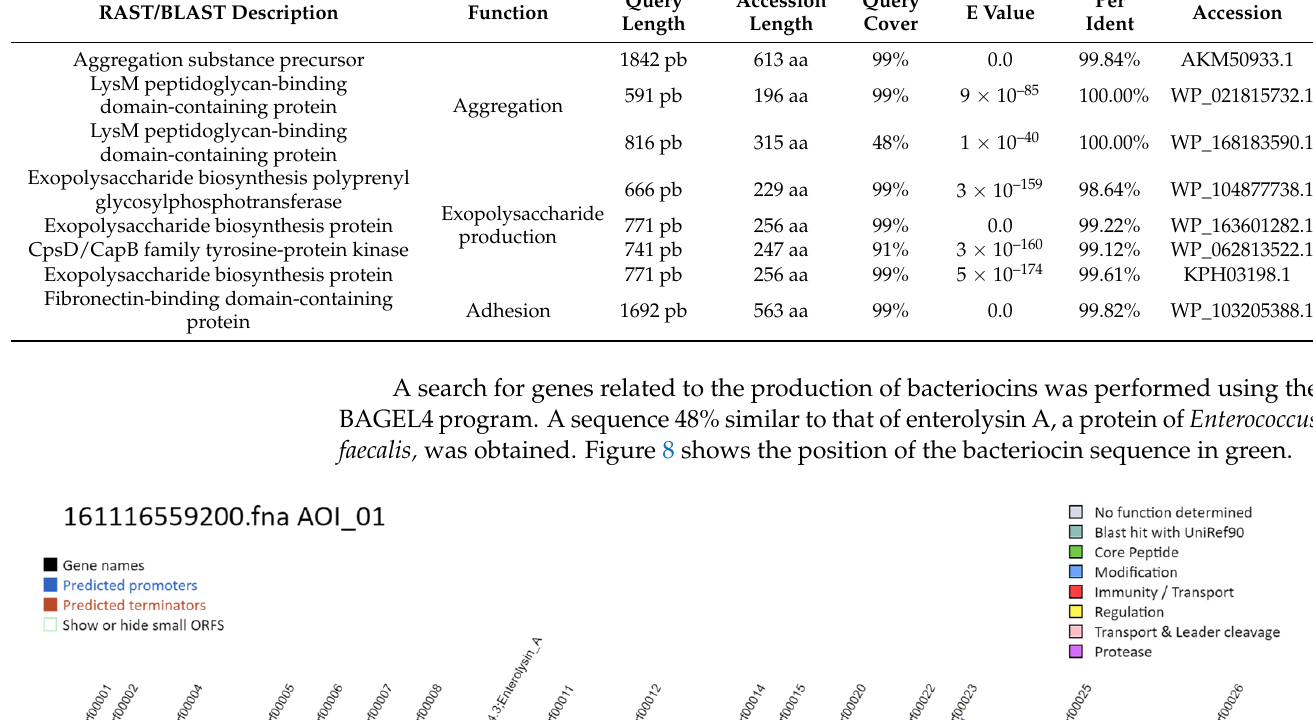
Table 3. Proteins potentially involved in the adhesion and aggregation properties of L. fermentum ATCC 23271 strain.